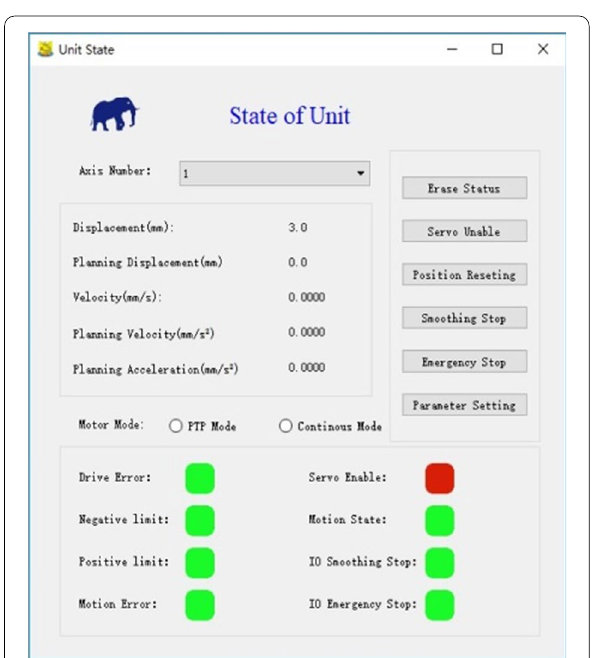
Figure 18 Status monitoring of parallel mechanism